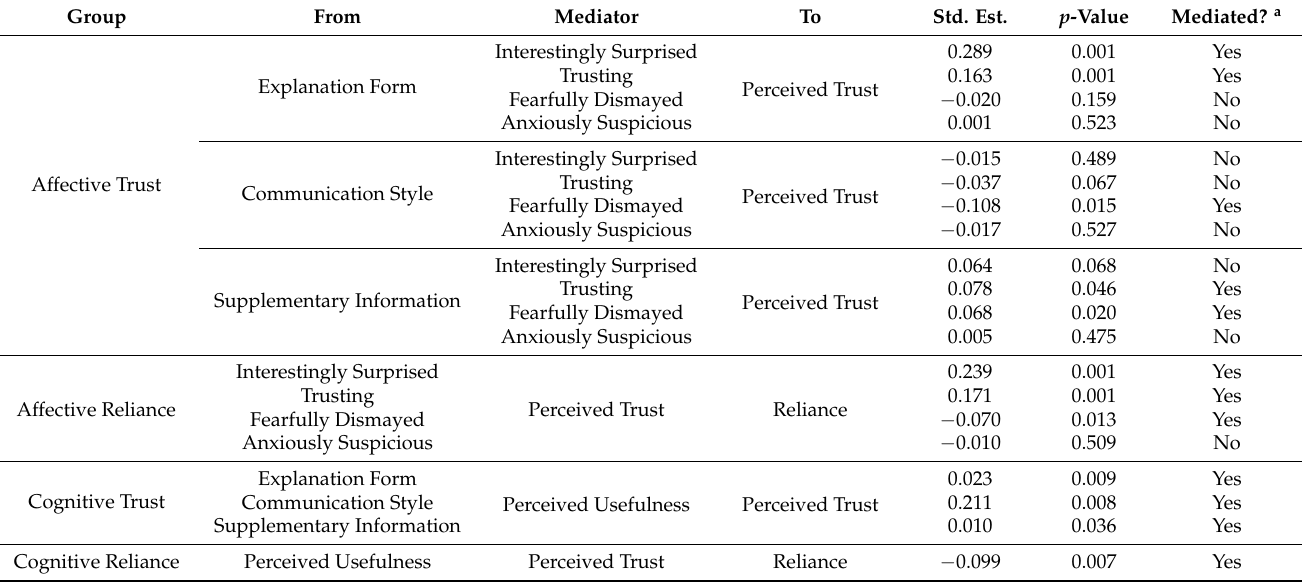
Table 8. Mediation effect